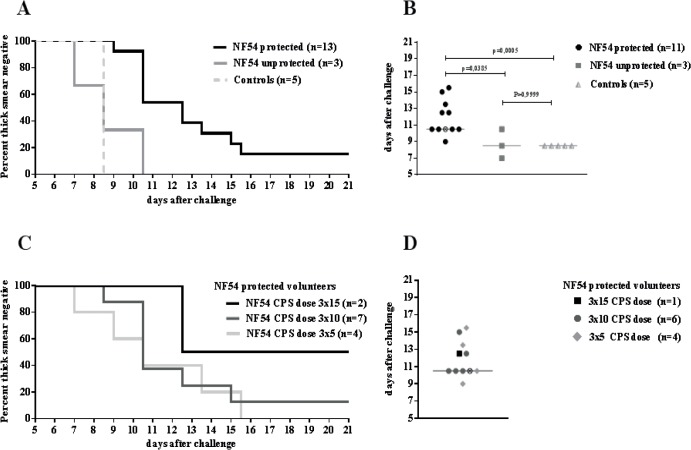
Protection and prepatent period after heterologous NF135.C10 challenge.
Left panels: Kaplan-Meier curves showing percentage of thick smear negative volunteers after NF135.C10 challenge according to previous NF54 protection status (A) and NF54 CPS-immunization dose (C). Right panels: The corresponding distribution of prepatent period of thick smear positive volunteers is shown in dot plots according to NF54 protection status (B) and NF54 CPS-immunization dose (D). Lines represent medians. ⨂ = Volunteer presumptively treated after NF54 challenge and considered NF54 protected.